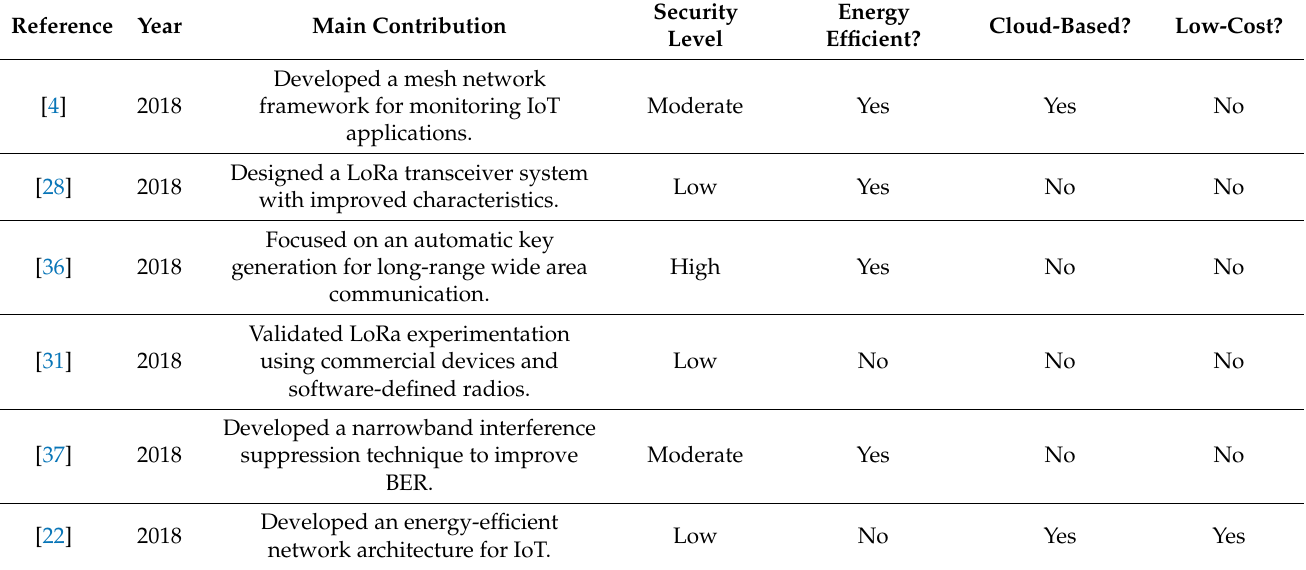
Table 2. Summary of the related work on long-range